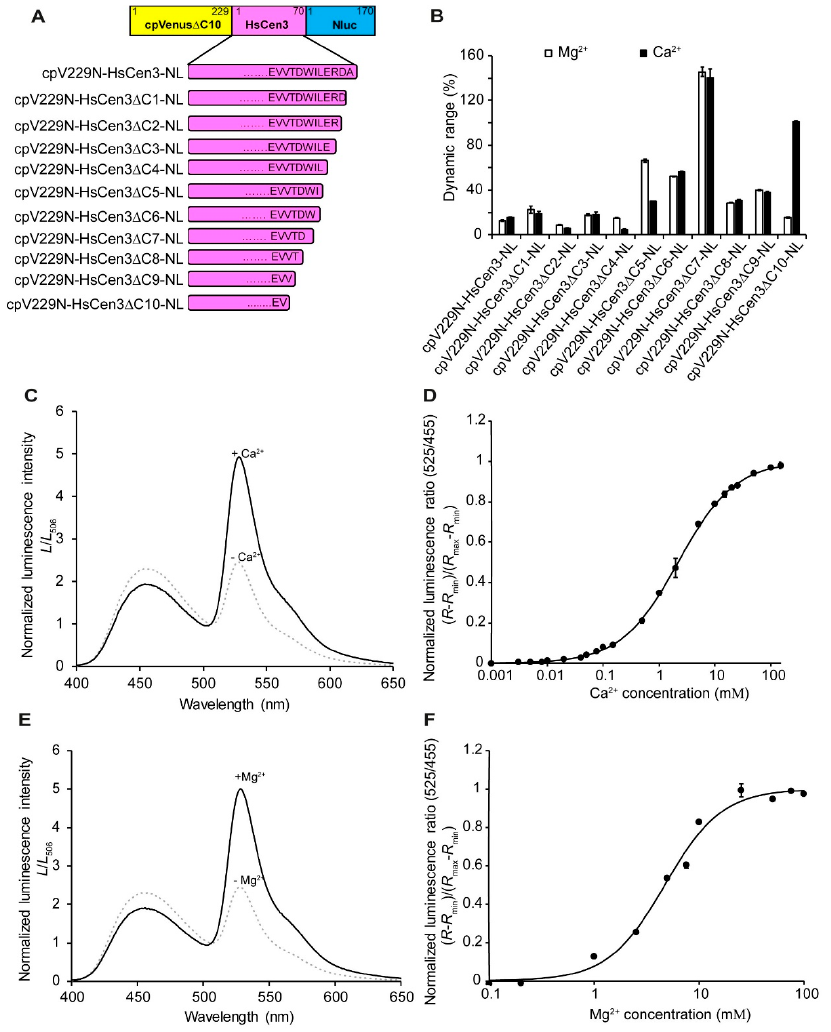
Figure 2. Development of ratiometric water hardness indicator and their in vitro properties ( A ) Domain structures of water hardness indicator candidates. HsCen3 with several deletions from the C-terminus was inserted between cpVenus Δ C10 and Nluc. ( B ) Dynamic ranges of the variants were calculated from the emission ratio (525 nm/455 nm) with and without 10 mM Ca 2+ /Mg 2+ . cpV229N–HsCen3 ∆ C7-NL showed the highest dynamic range. ( C , E ) Bioluminescence emission spectra of cpV229N–HsCen3 ∆ C7-NL in the presence (black line) and absence (dashed line) of Ca 2+ or Mg 2+ . ( D , F ) Titration curves of the emission ratio of cpV229N–HsCen3 ∆ C7-NL. Bioluminescence emission ratios (525 nm / 455 nm) with di ff erent concentrations of Ca 2 + and Mg 2 + have been plotted. The K d of each ion was calculated from the emission ratios (525 nm / 455 nm). Ratios were normalized by using the maximum ratio ( n =